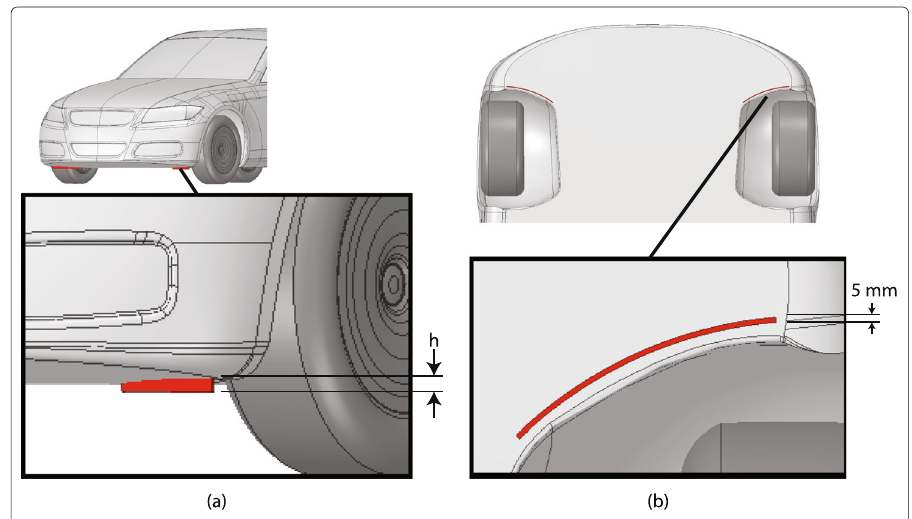
Fig. 2 Notchback DrivAer model with a conventional wheel deflector ( a ) front view and ( b ) bottom view